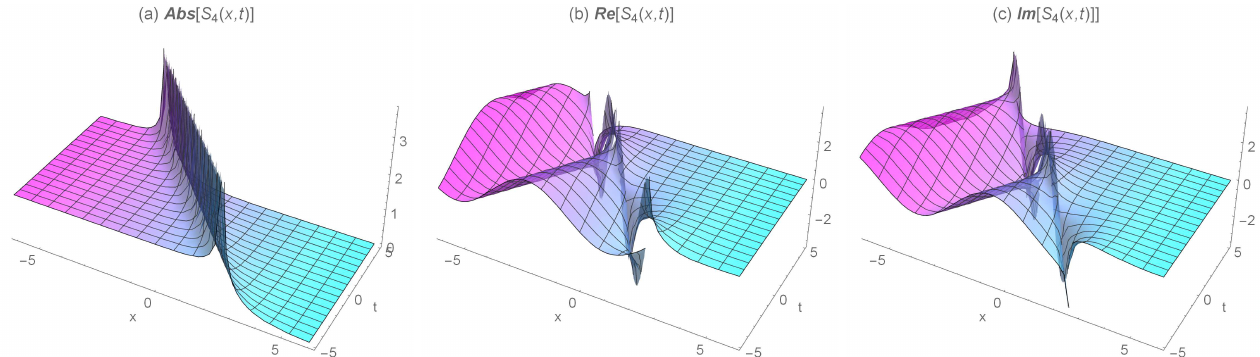
Figure 5. The 3D wave profiles for the absolute, real, and imaginary values of the singular kink-like soliton solution for b = 0.9, c = − 0.3, s = 1.5, k = 1, ϑ 0 = 0.2, ε 1 = 1, ε 2 = 1, ε 3 = 1.2, Ω = 0.5.